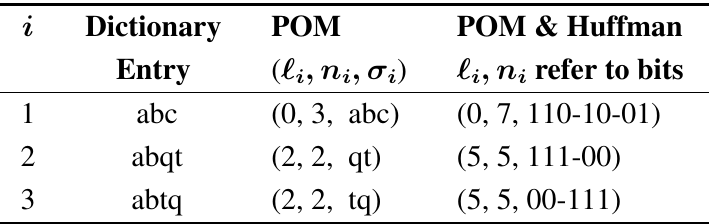
Table 2. Example for the need of a security